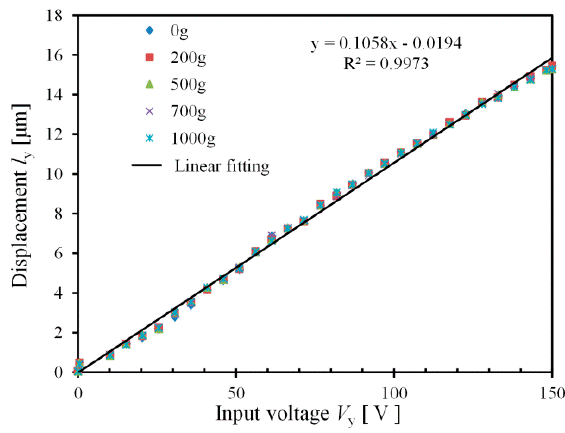
Figure 10. Performance of proposed 2-DOF platform under different output force.